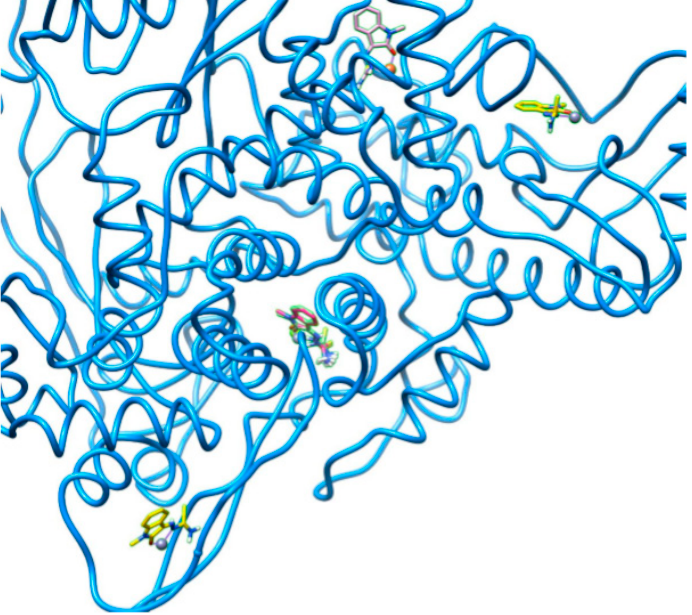
Figure 1. Visualization of low-energy docking sites in 6M71_A using Chimera software. Two binding pockets can be observed: one multi-occupant site and three sites with single occupants. Molecular graphics performed with UCSF Chimera, developed by the Resource for Biocomputing, Visualization, and Informatics at the University of California, San Francisco, with support from NIH P41-GM103311.